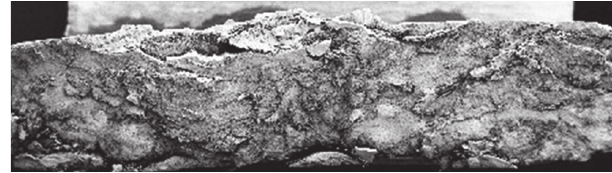
Figure 7. Cross-sectional view at the fracture surface of compression failed test